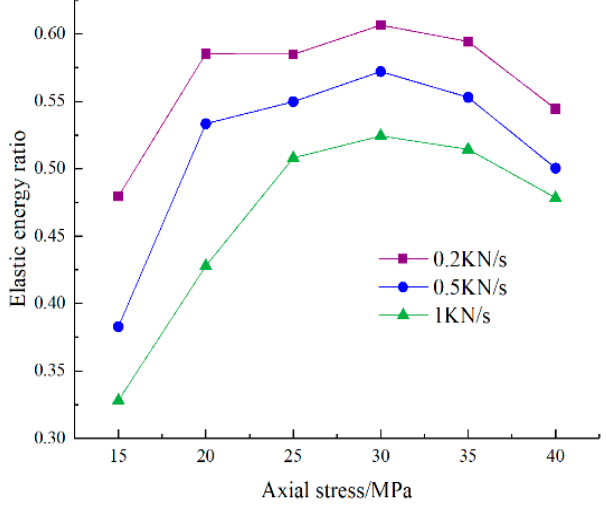
Figure 10. Elastic energy.